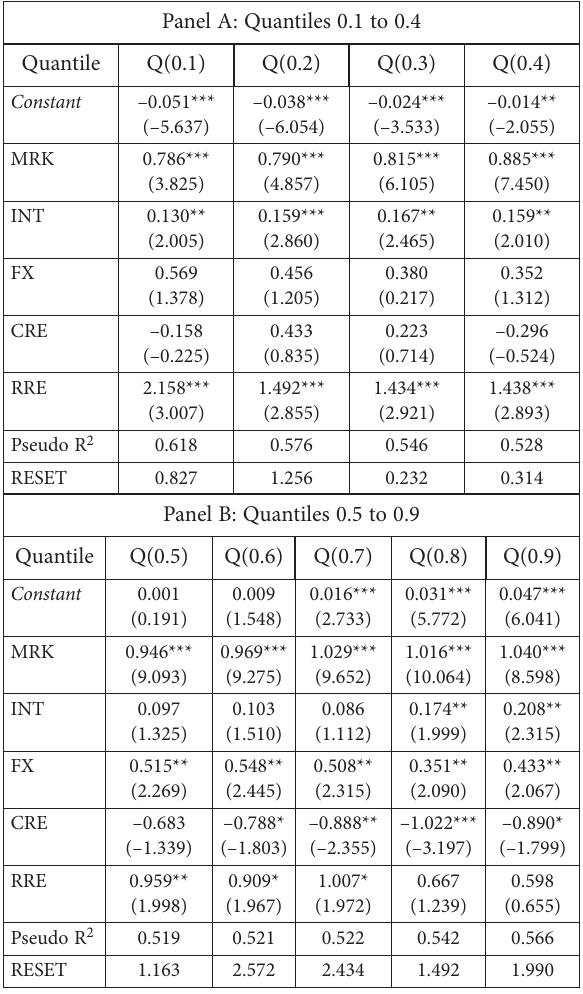
Table 3. QR estimates of bank stock return sensitivities Panel A: Quantiles 0.1 to